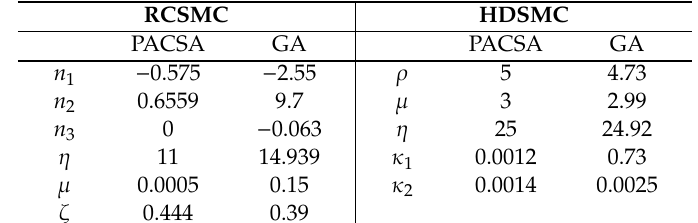
Table 5. Optimized parameters of the PACSA and GA.